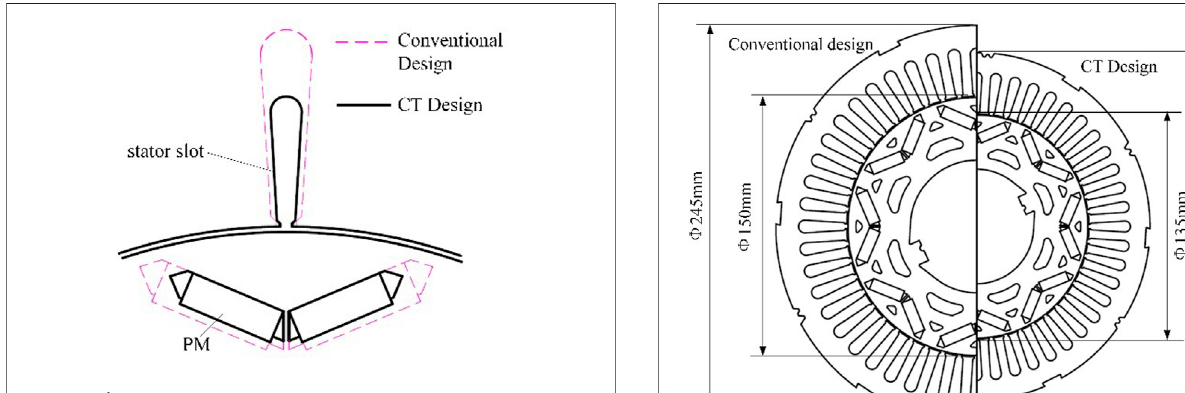
FIGURE 2 | Change of the slot and PM dimensions redesigned by the CT method.